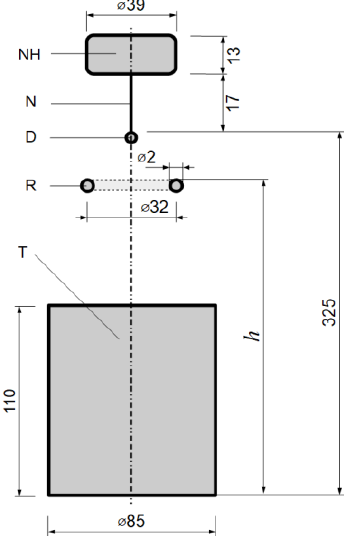
Figure 11. View of the model used in finite element method (FEM) computer simulation, based on the